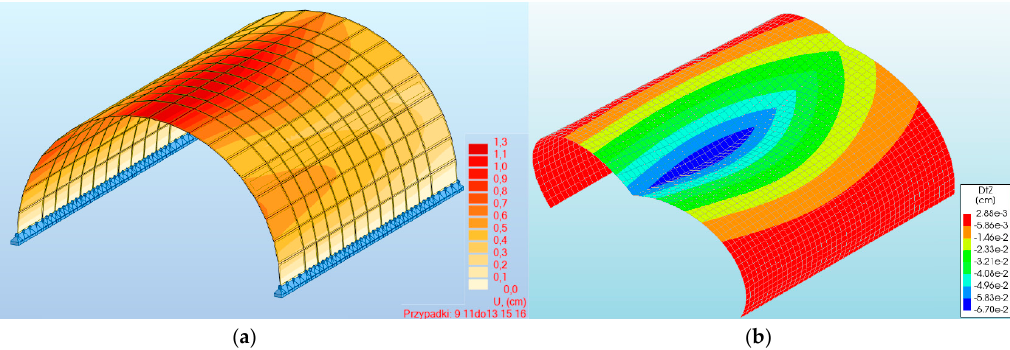
Figure 3. Maximal displacements of the three-hinged arch for program: ( a ) #1, ( b ) #2. Table 4. Juxtaposition of maximum internal forces in the masonry viaduct (three- and two-hinged arch) for the applied load combinations.